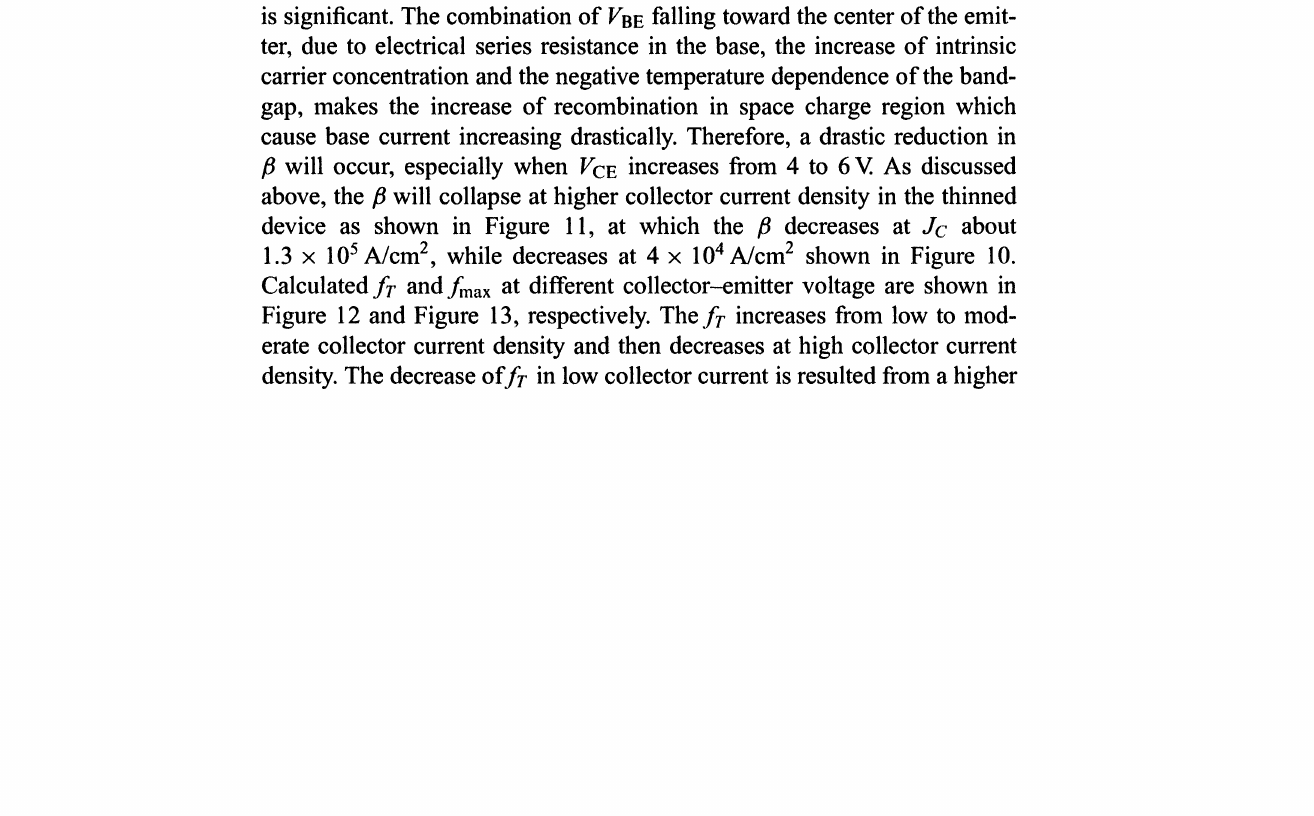
FIGURE 9 IV characteristics for the SI substrate with a thickness of